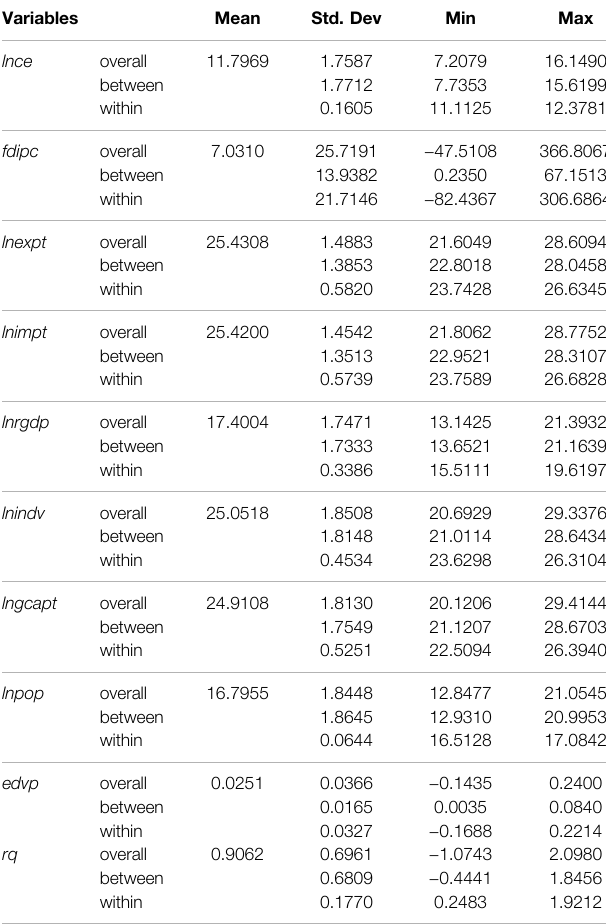
TABLE 1 | Descriptive statistics of panel